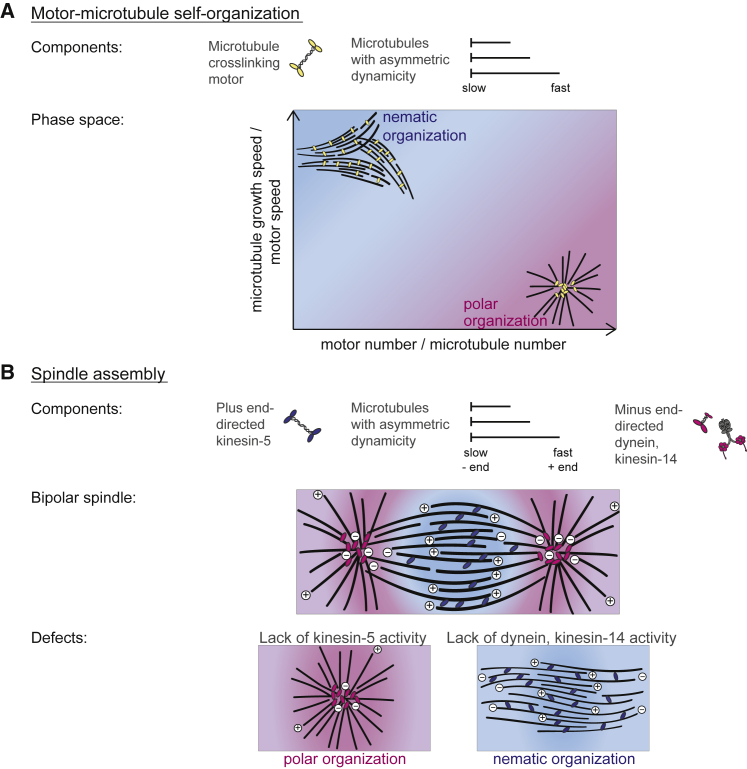
Summarizing Scheme of the Rules of Active Network Self-Organization(A) Key molecular components and the organizational phase space defined by the two identified control parameters that determine the outcome of microtubule/motor network self-organization.(B) Relevance of the control parameter-based rules for normal bipolar spindle assembly in cells and their consequences for the characteristic shapes of defective spindles after motor inactivation.